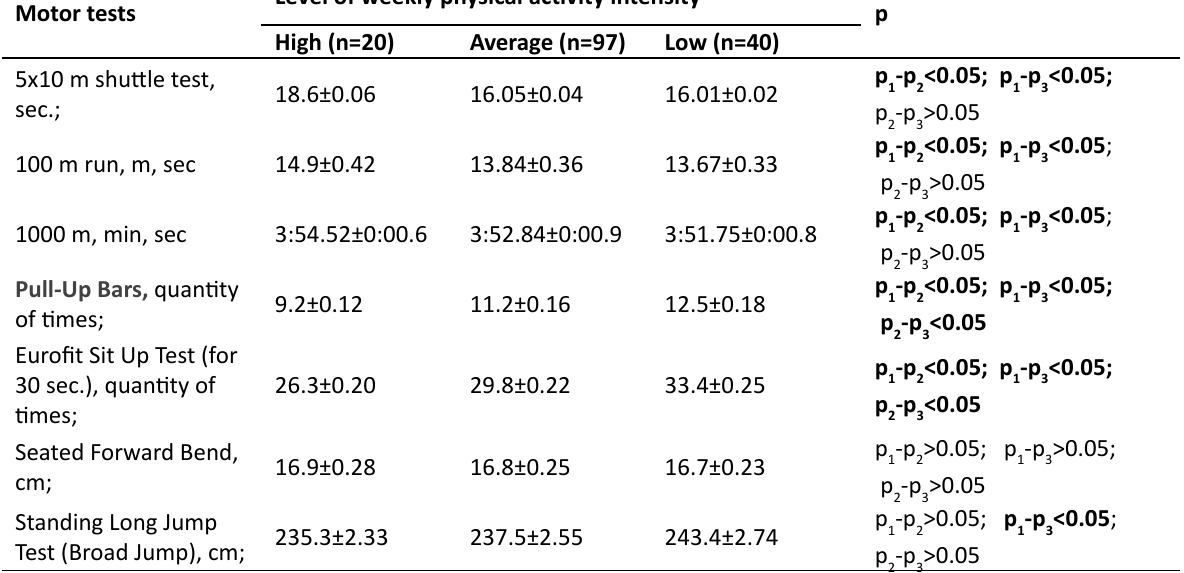
Fig. The students’ division by levels of metabolic equivalent of task of weekly physical activity (%). Table 4. Results of boys motor tests (M ± m) Motor